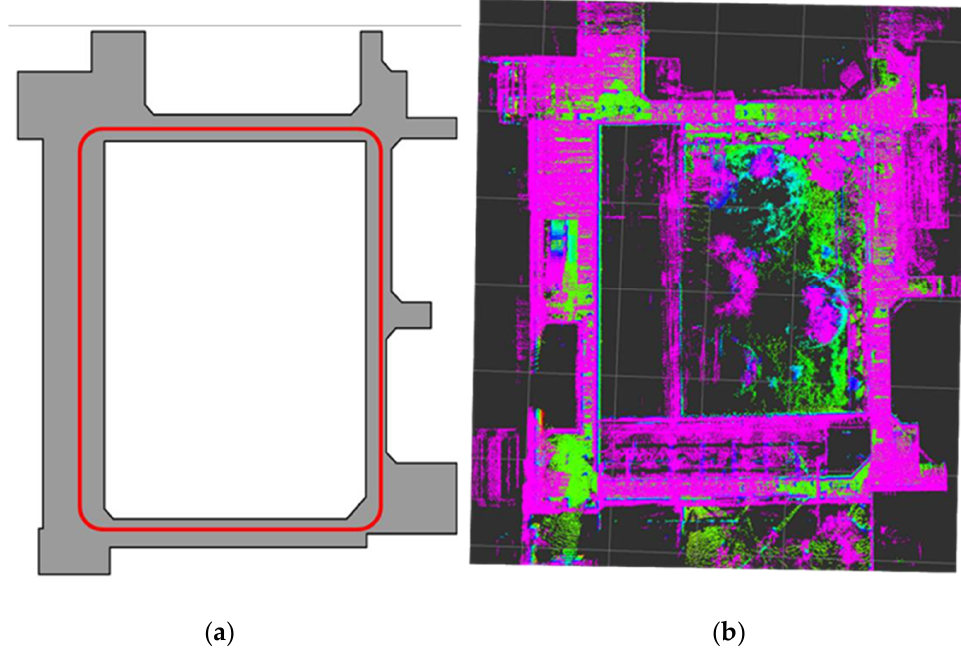
Figure 6. ( a ) Trajectory and floor plan of the corridor in the B-building of the University of Applied Sciences Offenburg, Germany. ( b ) Map created with hdl_graph_slam.